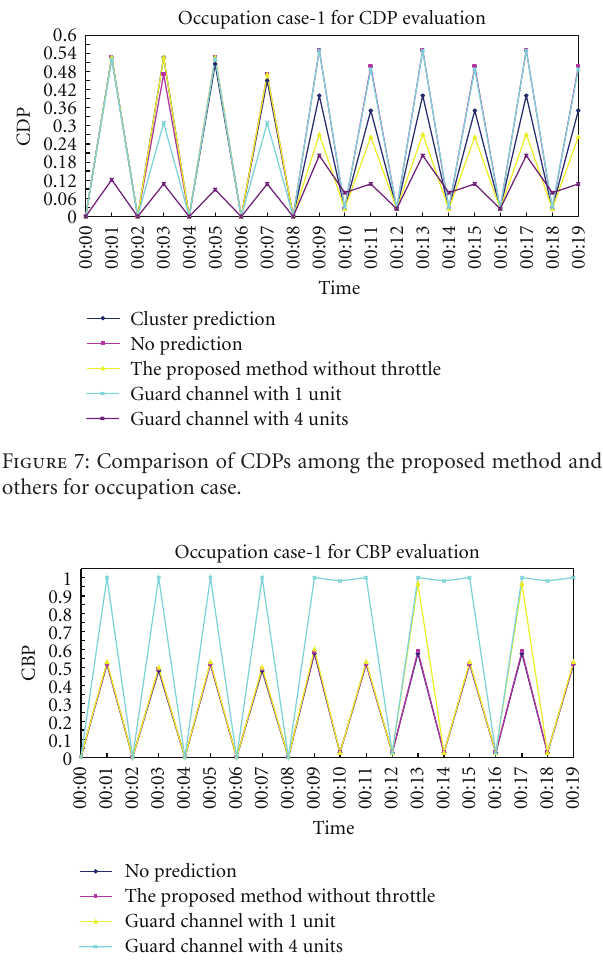
Figure 8: Comparison of CBPs among the proposed method and others for occupation case-1.